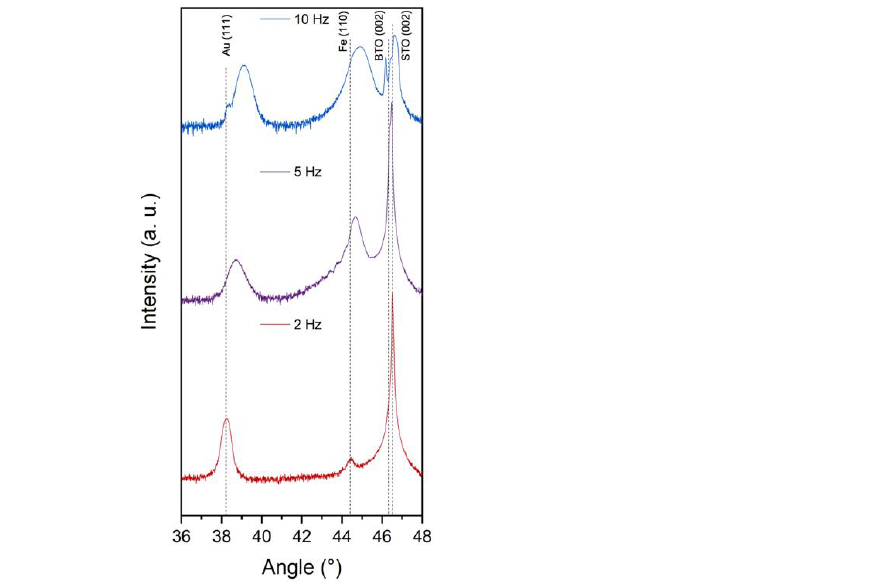
Figure 4. XRD 𝛳 – 2 𝛳 results for all three samples deposited under different laser frequency. Figure 4. XRD θ –2 θ results for all three samples deposited under different laser